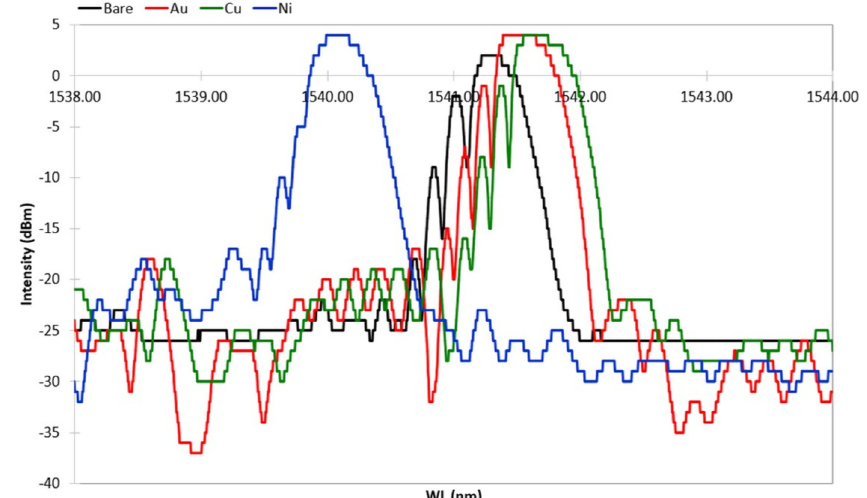
Figure 7. Spectral variation after the four steps of the sample production process. All plots were recorded at the same room temperature, 24 h after each production process step to allow thermal and transitory strain